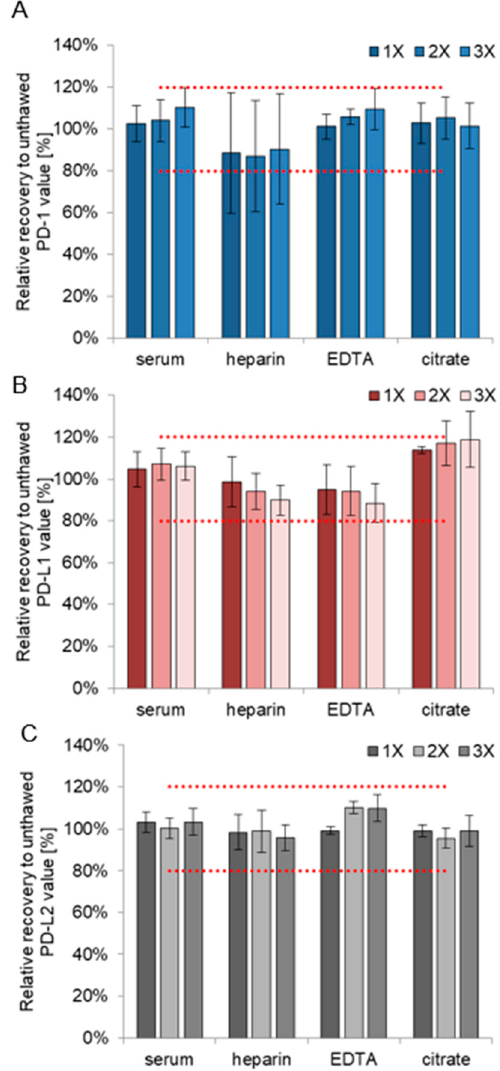
Figure 5. Recoveries after up to three freeze–thaw cycles for PD-1 ( A ), PD-L1 ( B ) and PD-L2 ( C ). The figure compares unthawed to once, twice, and three times refrozen sample values. The samples are taken from five patients in four different blood sampling tubes (serum, heparin, EDTA, and citrate). Dotted red lines encompass the range between 80% and 120%.